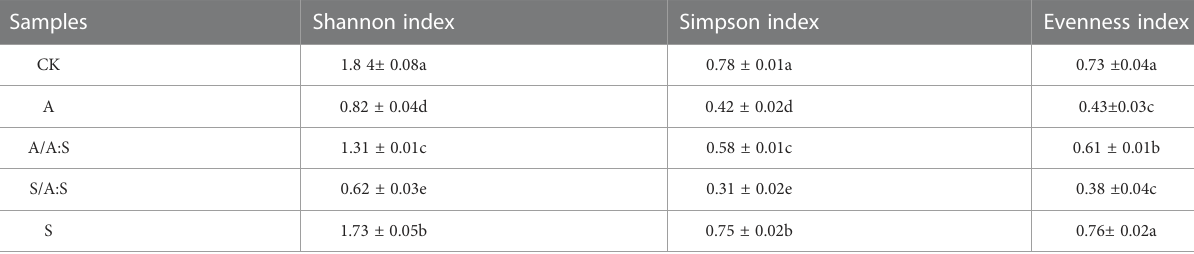
TABLE 1 The bacillus diversity analysis of different soil.